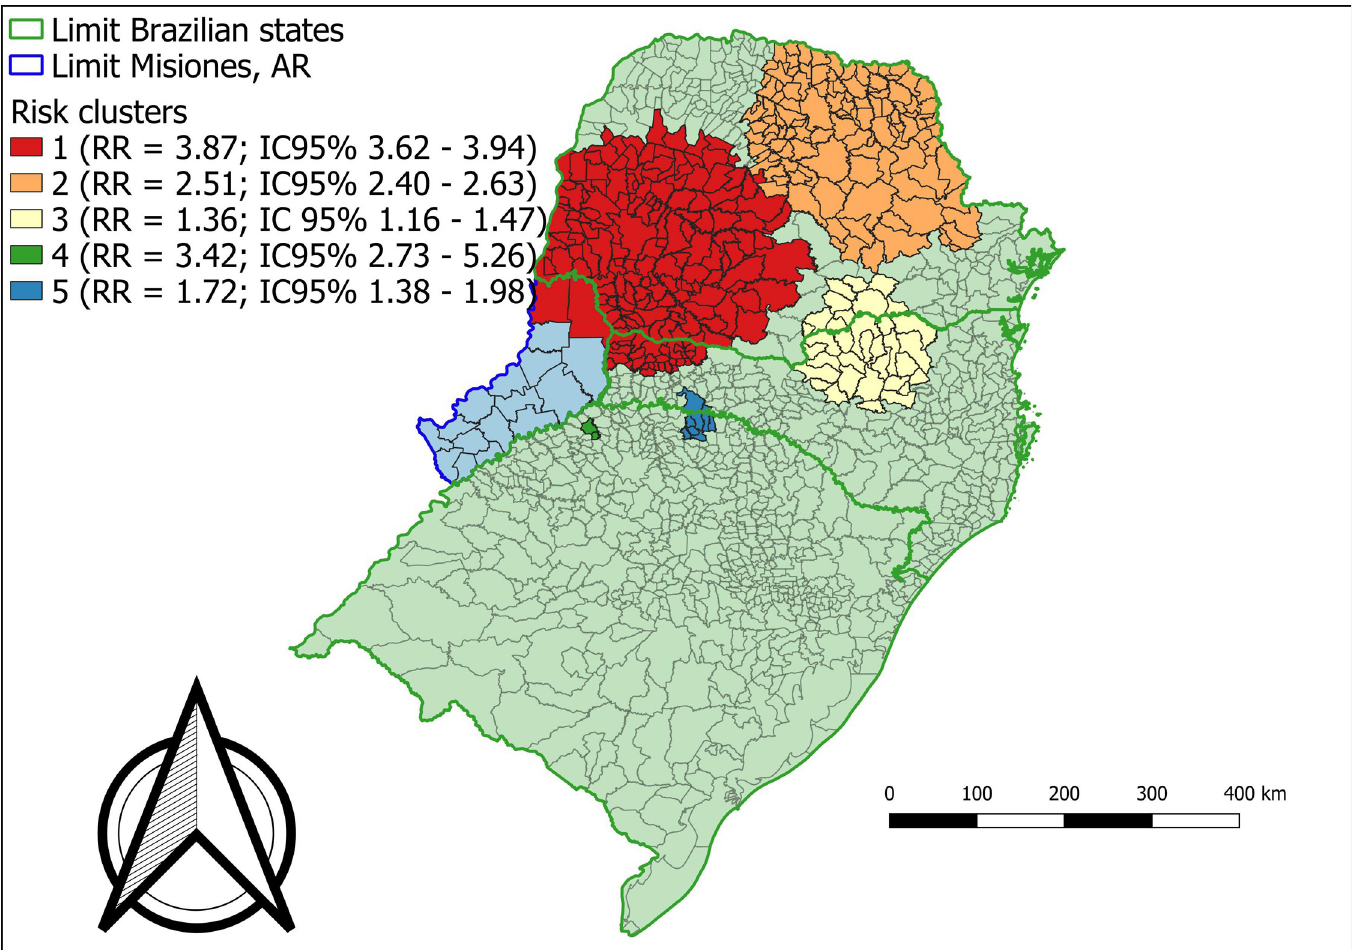
Fig 3. Areas of relative risk for new cases of leprosy in Southern Brazil and Misiones—Argentina, 2010 to 2016.